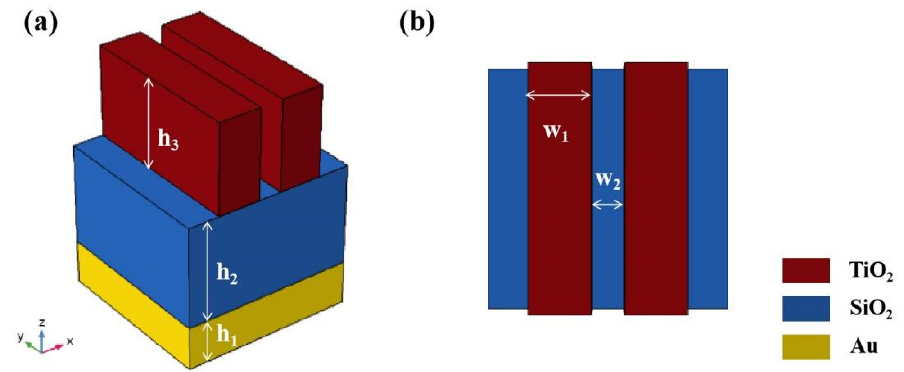
Figure 1. ( a , b ) Three-dimensional view and a top view of the designed absorber, respectively.